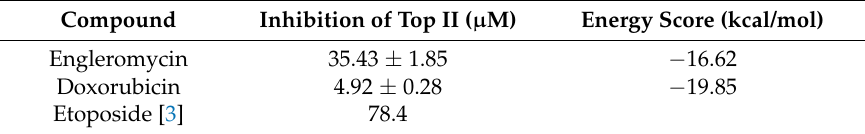
Table 2. Top II inhibitory activities and energy scores of engleromycin and doxorubicin.